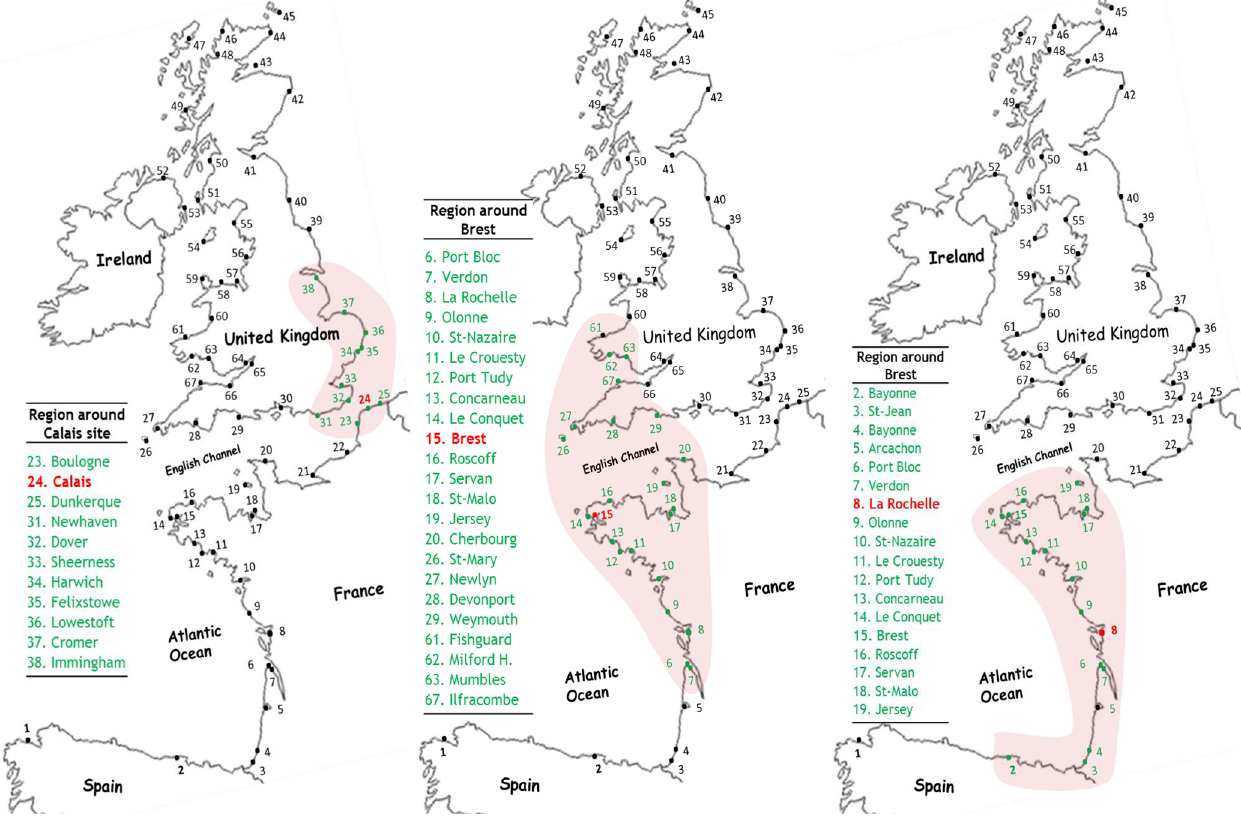
Figure 5. Physically homogenous regions (the list of sites belonging to a region are surrounded by red zones) for Calais, Brest, and La Rochelle. Neighboring sites are represented with green dots (target sites are represented with red dots). Target sites are not close to a